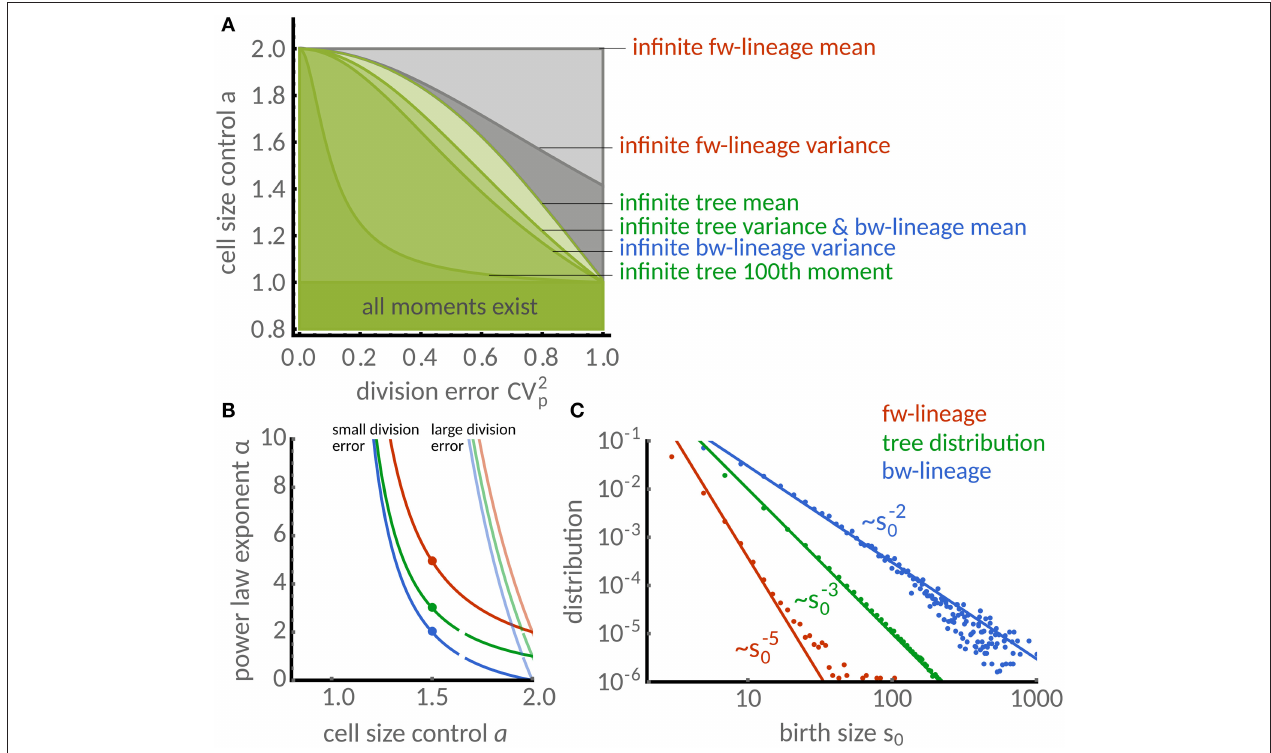
FIGURE 4 | Distributions of timer-like mechanisms display different power laws in single cells and populations. (A) Regions in parameter space a (cell size control) and CV 2 p (division error) under which cell-size homeostasis is established in terms of first and second moments. Lines separate the regions above which forward lineages have infinite mean (light gray) and variance (dark gray), the population tree has infinite mean (very light green) and variance (light green) and similarly for the backward lineages (light and medium green). Also shown is the line above which the 100 th tree moment is infinite (dark green) computed for a symmetric beta distribution. Note that for a ≤ 1 all moments are finite. (B) Power law exponent of size distribution in dependence of the size control parameter a . The exponents are higher for low division errors (light colors, symmetric beta distribution with CV 2 p = 0.005) than for large division errors (full colors, CV 2 p = 1 / 3) but are generally different for forward (red), backward lineages (blue) and tree distributions (green). (C) Comparison of power laws obtained from theory [ a = 1.5, compare dots in (B) ] show excellent agreement with stochastic simulations. The power law exponent is α ≈ 5 in forward lineages (first three moments exist). In contrast, α = 3 (finite mean but infinite variance) for the tree distribution and α = 2 (infinite mean and variance) for the backward lineage